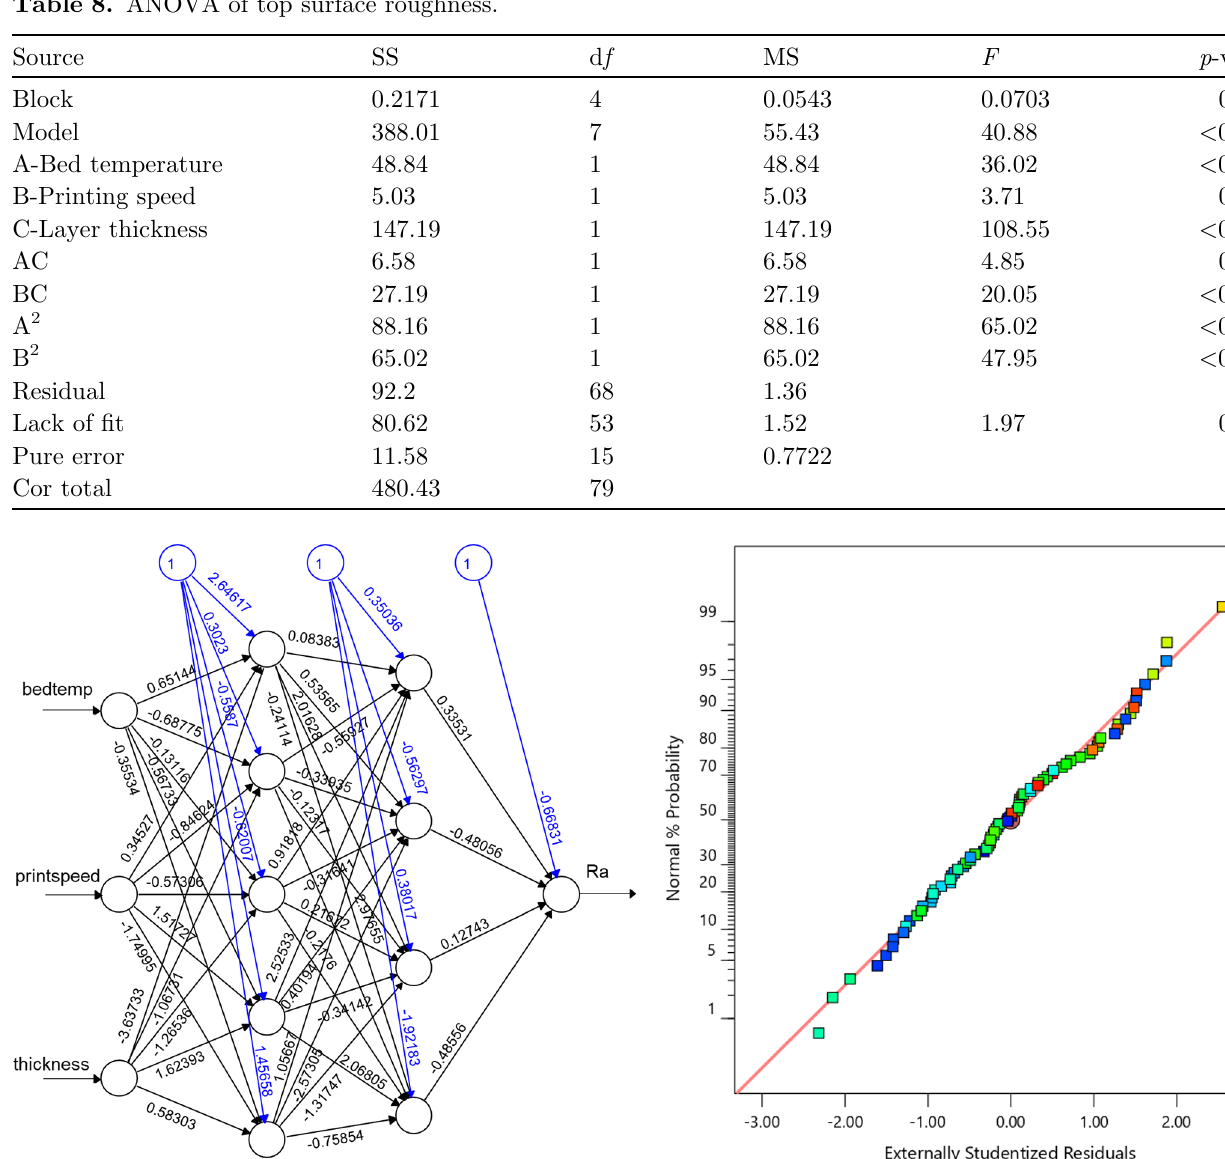
Fig. 10. Neural network: GRPROP, S= {3, 5, 4, 1}.